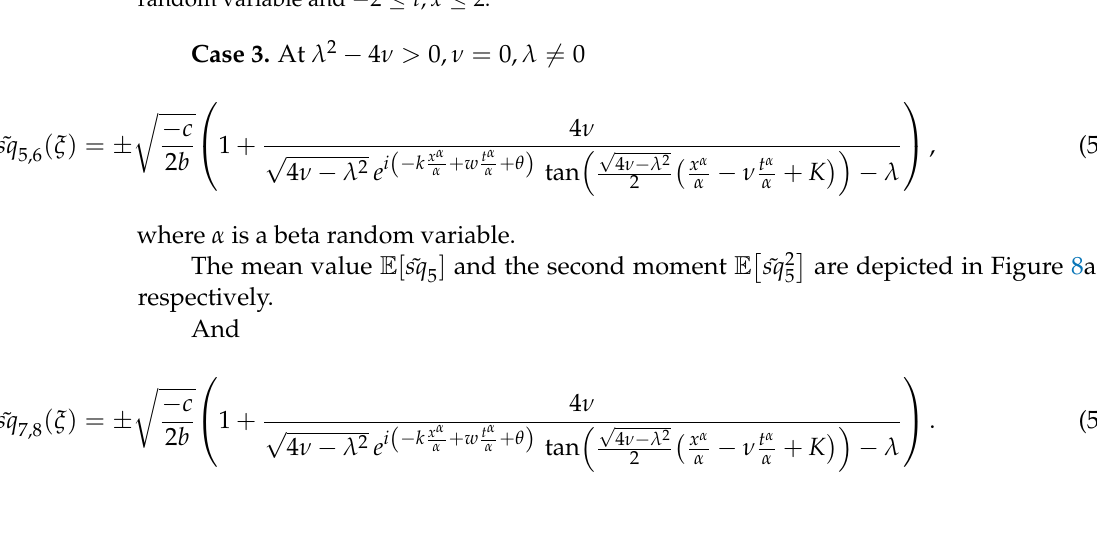
Figure 7. The first and second moments for the random solution ˜ sq random variable and − 2 ≤ t , x ≤